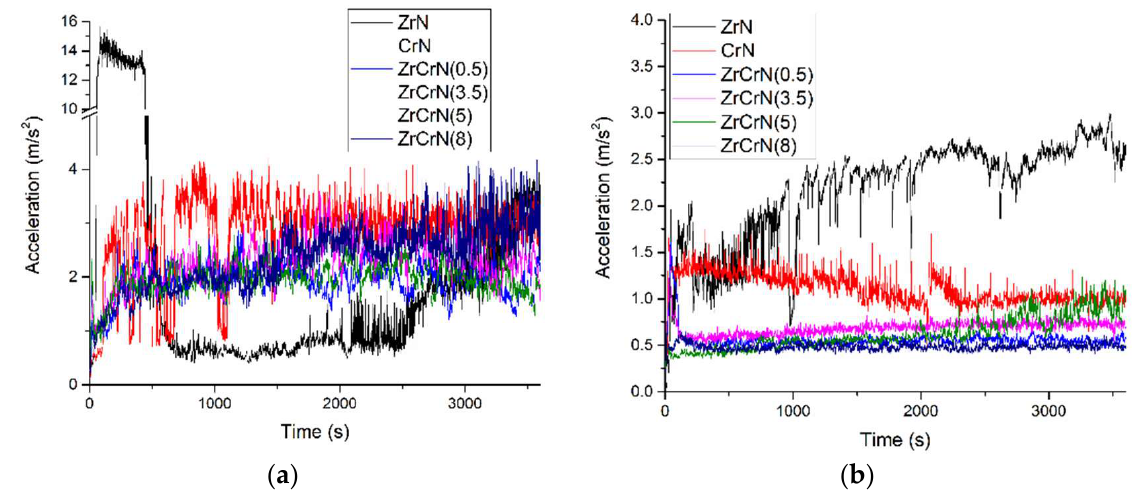
Figure 3. Vibration acceleration waveforms from sliding at 1N ( a ) and 6N ( b ).